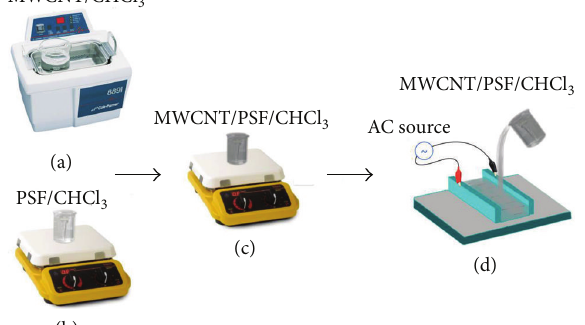
Figure 1: Schematic of the solution casting process for the prepara- tion of MWCNT/PSF composites with electric field-aligned MWC- NTs.